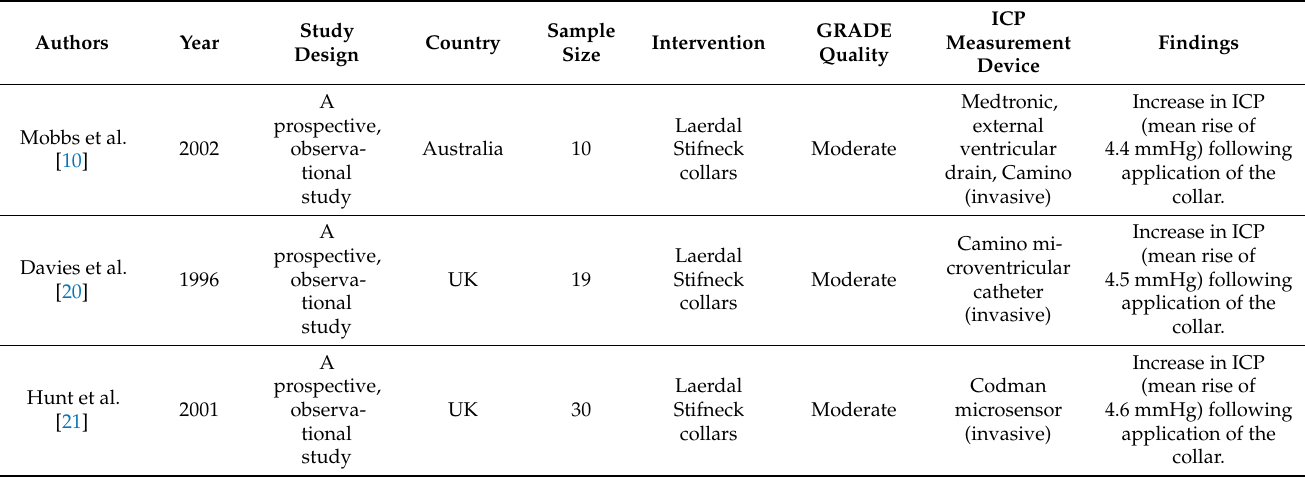
Table 2. Characteristics of the included studies identified from the systematic search.